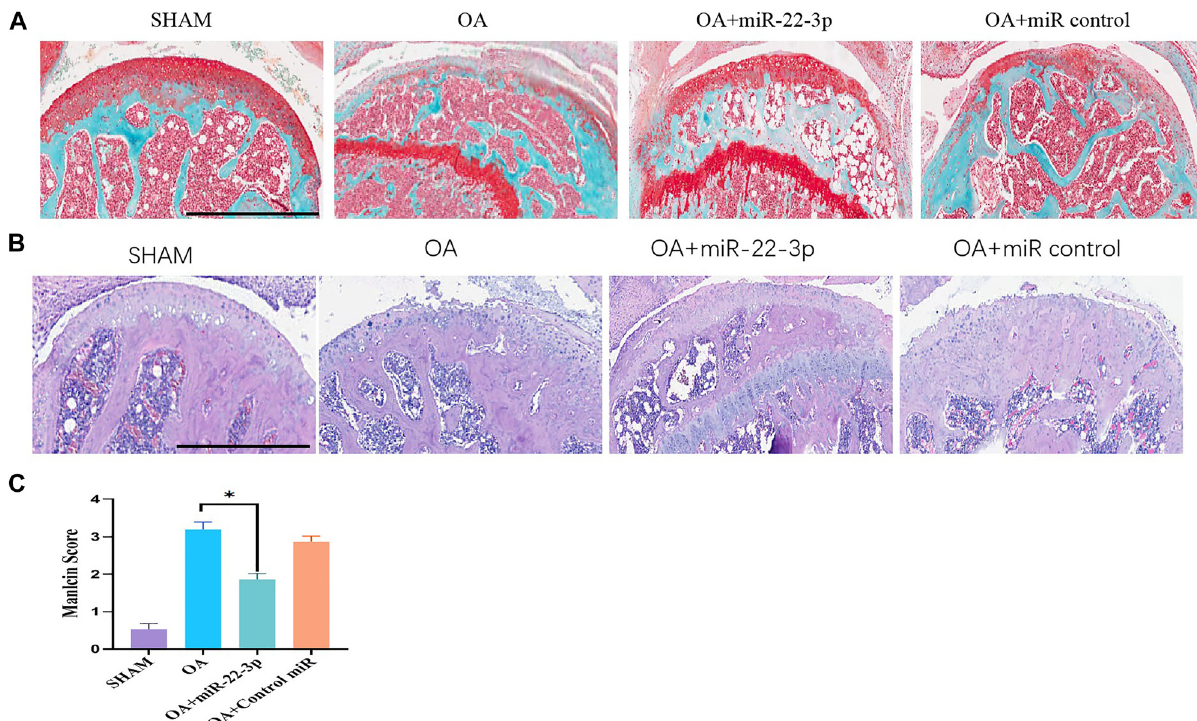
Figure 6: (A) AAV-miR22-3p treatment relieved osteoarthritis in vivo evaluated by Safranin O-fast green staining. The tissue sections were routinely deparaf fi nized, and then the sections were soaked in xylene solution for 10 min. After treatment with the ethanol, the sections were stained with fast-green. After washing, the sample was stained with safranin O solution, the sections were then observed using a light microscope. (B) The effect of AAV-miR22-3p treatment on OA determined by HE staining. (C) Markin score between AAV-miR-22-3p treatment group and operation